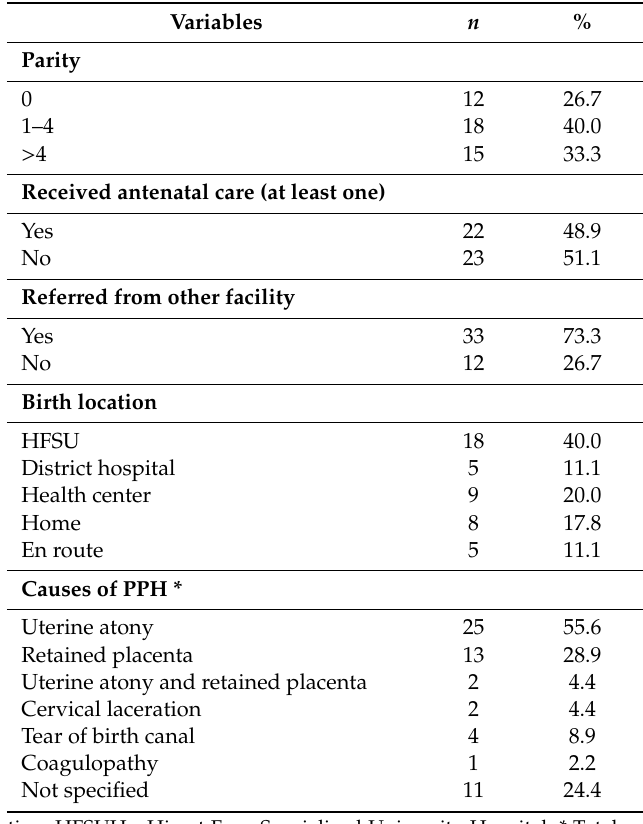
Table 1. Sociodemographic and obstetric conditions of women with postpartum hemorrhage (PPH) in a university hospital in eastern Ethiopia, 2020.